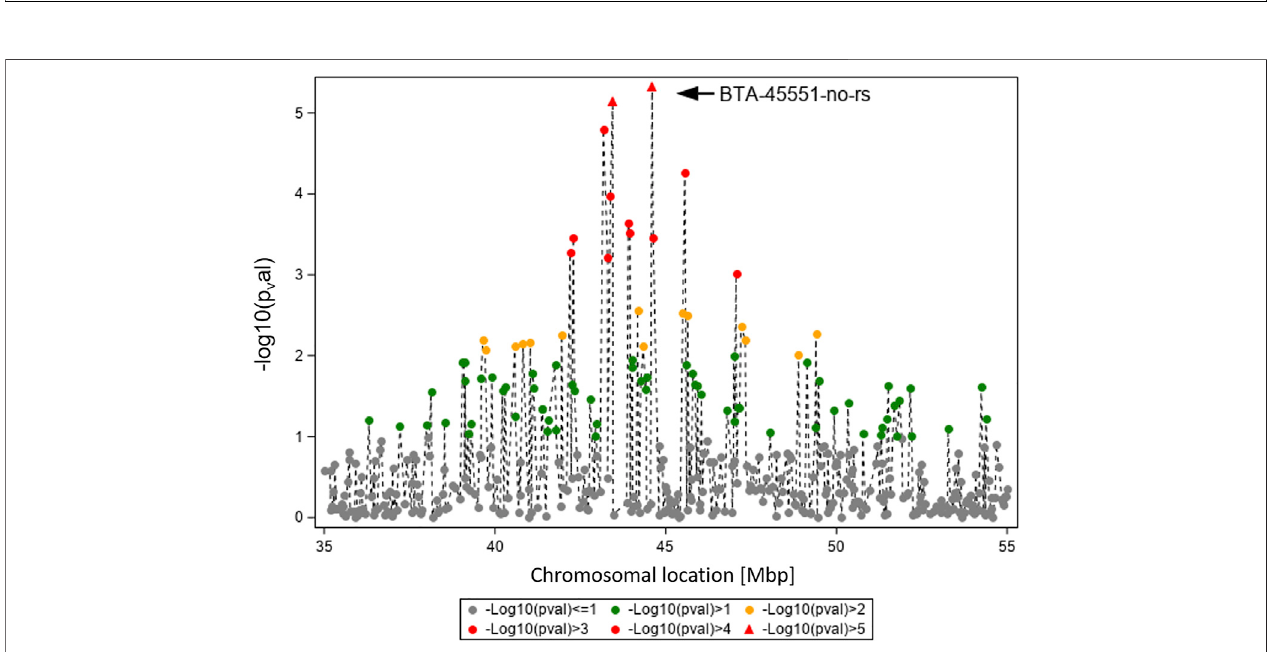
FIGURE 4 | Overview of the chromosomal region around BTA-45551-no-rs on BTA19 for trait TBIN. The -log10 p -values of detected SNP are shown. The strongesteffectcouldbecalculatedforSNPBTA-45551-no-rs(blackarrowhead).Analogousto Figure3 ,SNPwith p -values < 1.5andSNPwithSNP-genotypes < 100 animals for the rarer homozygous genotype are not